Question: Write a descriptive caption for this figure.
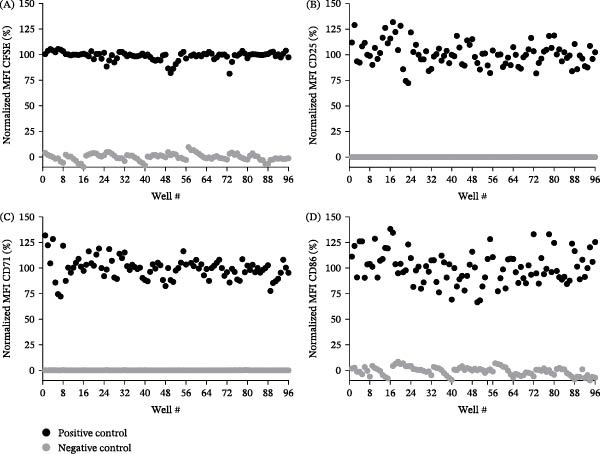
Answer: Assay signal distribution of CFSE (A), CD25 (B), CD71 (C) on T cells, and CD86 (D) on B cells following activation with anti‐CD3 for 72 h. Each plot shows the scatter distribution of normalized mean values for negative (gray) and positive (black) controls from three independent experiments performed on separate days. Positive and negative controls were arranged in alternating rows across the 96‐well plate, and their positions were shifted between experiments to minimize positional bias. Corresponding Z‐factor values calculated from these control distributions are indicated in the Results section.